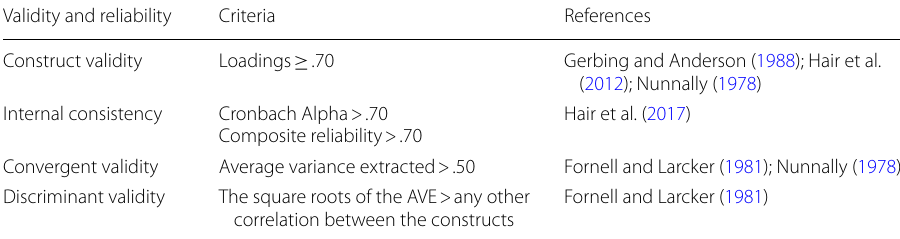
Table 4 The criteria for assessment of the measurement model Validity and